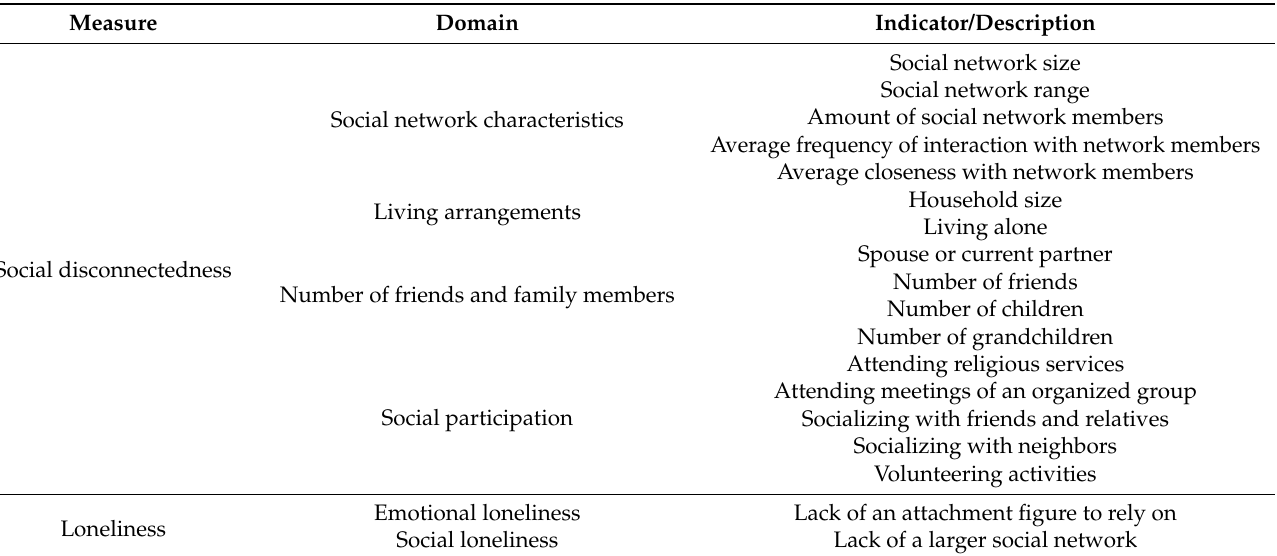
Table 1. Domains and description of the indicators of social isolation (adapted from Cornwell and Waite (2009)